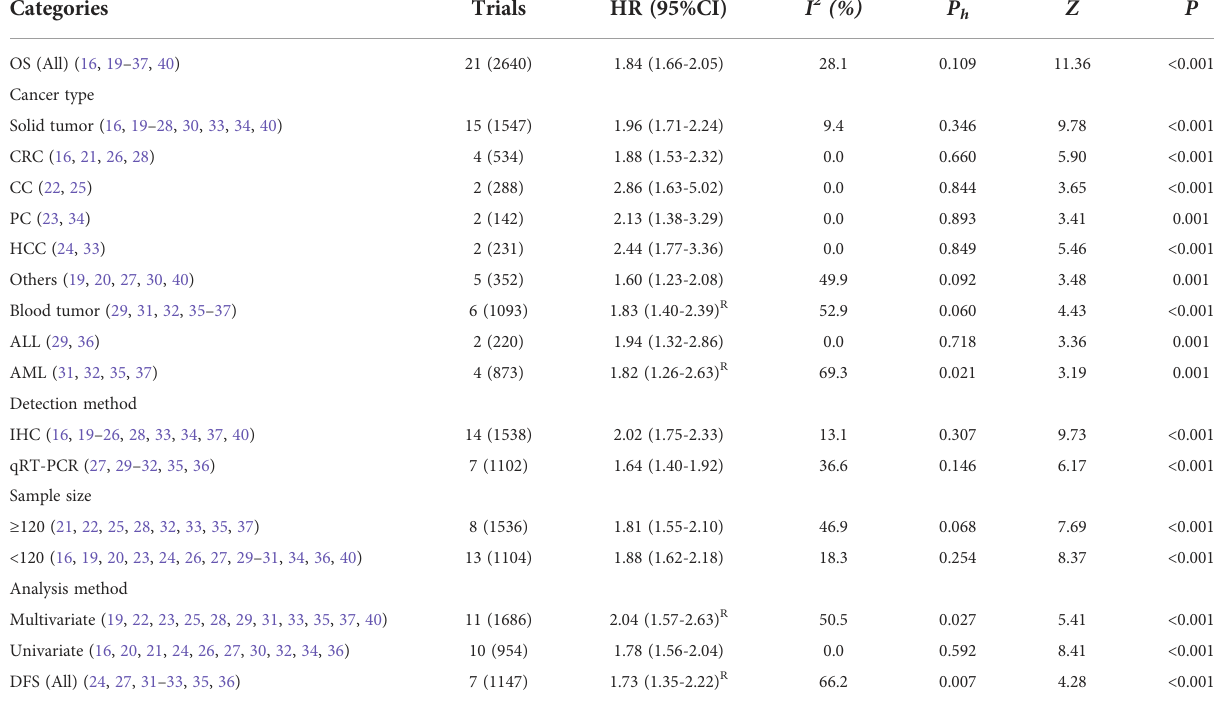
TABLE 2 Summary of the meta-analysis